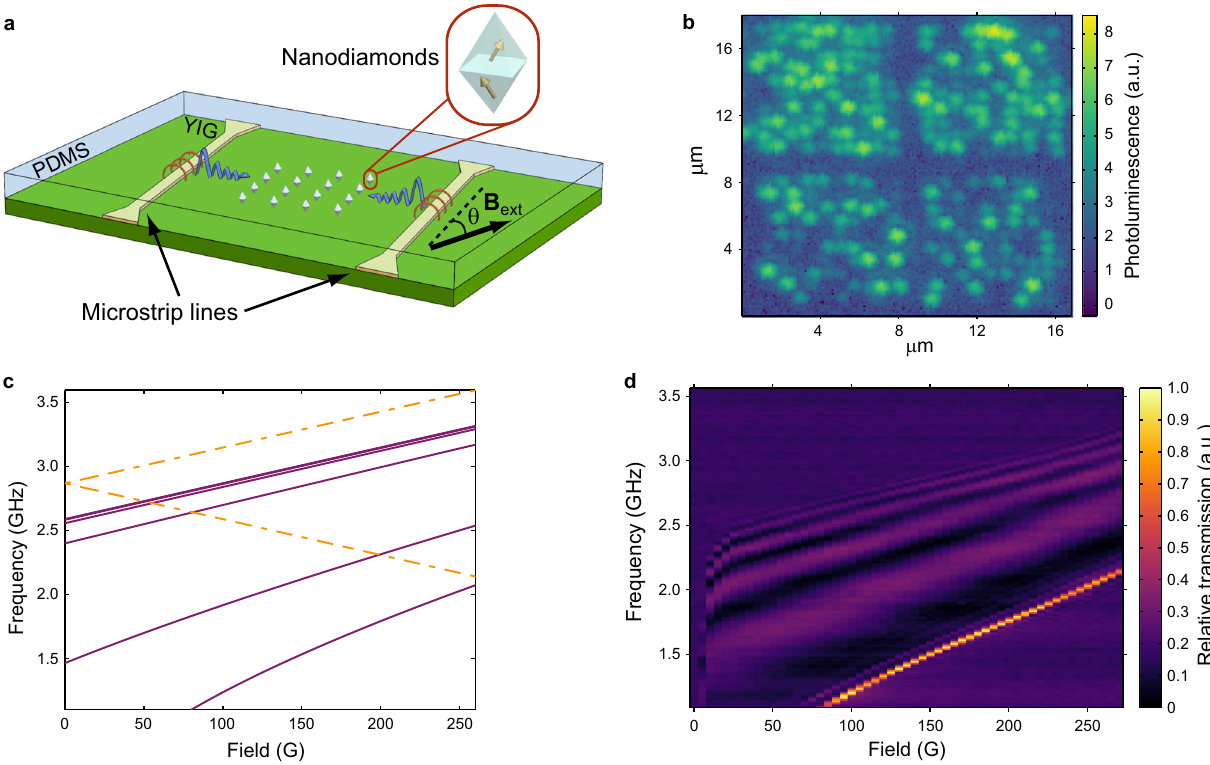
Fig. 1 Setup and dispersion relation of the surface con fi ned spin wave modes. a , Sample schematics. The ferromagnetic layer is a 3.08 μ m thick single-crystal YIG fi lm epitaxially grown on a 500 μ m GGG substrate. A ~300 μ m thick PDMS strip with an array of NDs embedded on its surface is placed in contact with the YIG substrate. To apply and detect microwave fi elds, pairs of 5 μ m wide microstrip lines (MSL) are patterned with different separations on the YIG. Microwave magnetic fi elds ( red circles ) and propagating spin waves ( purple lines ) are indicated. An external magnetic fi eld ( B ext ) is applied at an angle θ with respect to the MSLs. The arrows in the ND represent the NV center spins, with each ND containing hundreds of NV centers. b , Spatial photoluminescence scan of ND arrays collected using a confocal microscopy setup. c , Simulated SW spectrum of the YIG sample in the case of magnetic fi eld parallel to the MSLs. The dashed lines enclose the range of frequencies where the NV centers ’ ground state spin resonances are located. d , Microwave transmission spectrum collected using two MSLs 100 μ m apart as a function of the externally applied magnetic fi eld for θ = 0. The data for 0 G were subtracted from the data at higher fi elds to eliminate features that are not fi eld